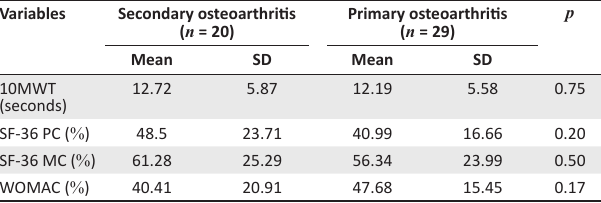
TABLE 3: Comparison of activity and participation in primary versus secondary osteoarthritis. Variables